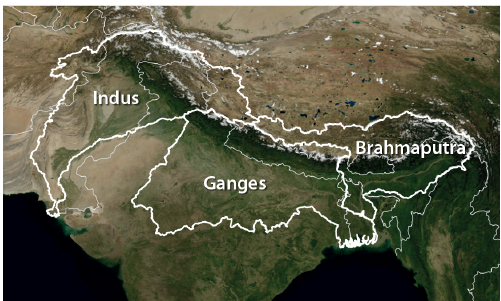
Figure 1. Map of the region, with the Indus, Ganges and Brahmapu- tra basins outlined in white. Thinner outlines are national borders. Background: NASA Visible